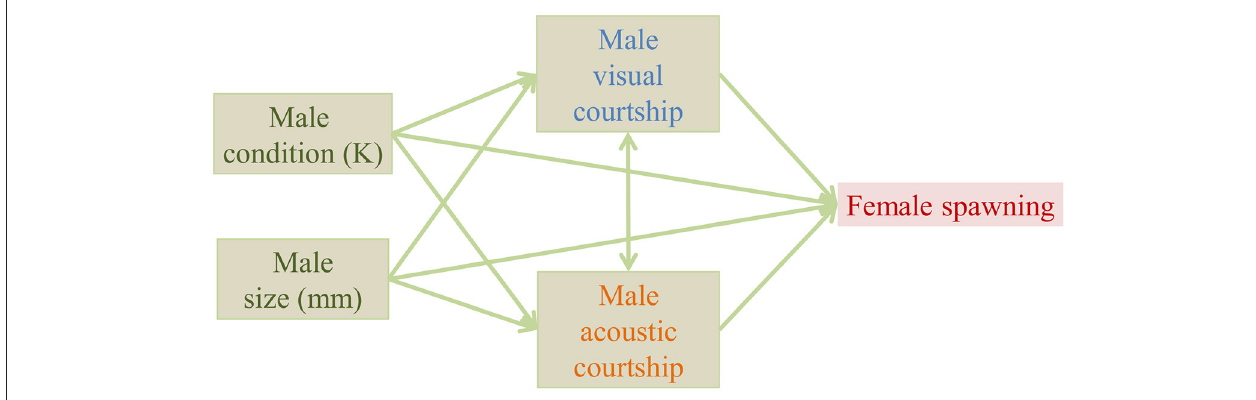
FIGURE 2 | Proposed path of measured variables potentially affecting the likelihood of female spawning in a Painted Goby aquarium